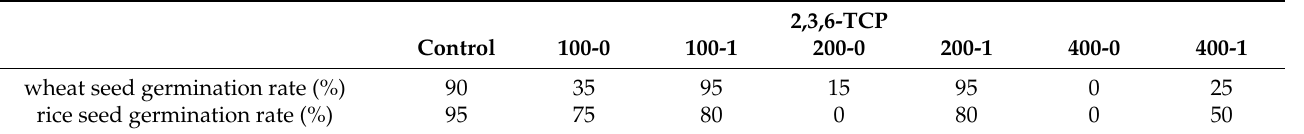
Table 5. Effects of different concentrations of 2,3,6-TCP on the germination rates of wheat and rice seeds before and after degradation by LAC-4 laccase. 2,3,6-TCP Control 100-0 100-1 200-0 200-1 400-0 400-1 90 35 95 15 95